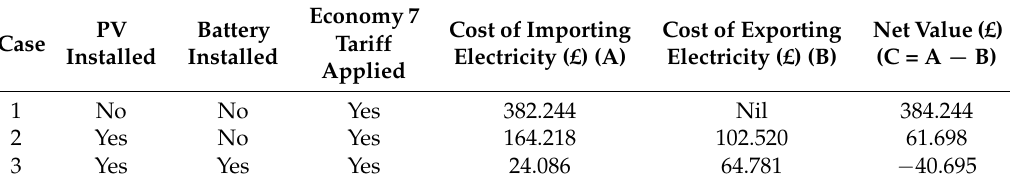
Figure 8. State of charge of the two batteries. Table 1. Results of Cases 1, 2, and 3.